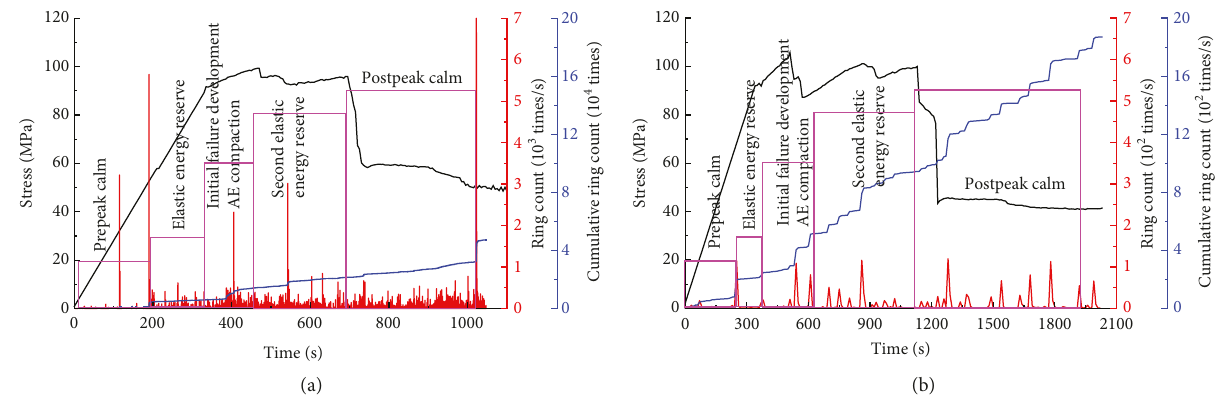
Figure 6: Ring count-axial stress-time relationship curve. (a) No. 2 RCTMC sample with 1: 8 cement-to-tailings ratio and 70% slurry content. (b) No. 1 RCTMC sample with 1 :6 cement-to-tailings ratio and 70% slurry content.